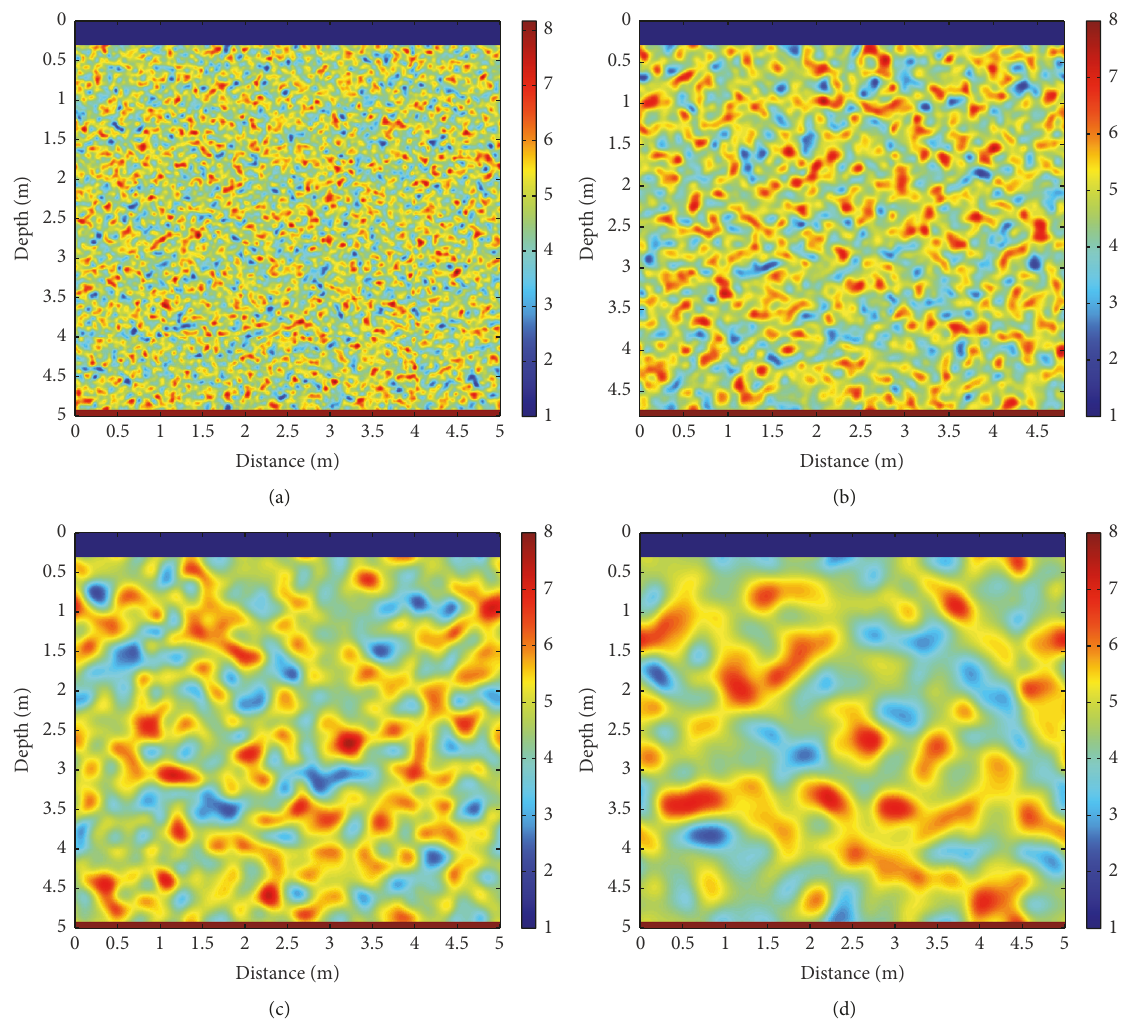
Figure 2: The discrete heterogeneous medium models, (a), (b), (c), and (d), with different autocorrelation lengths of 0.05 m, 0.1m, 0.2 m, and 0.3 m, respectively.